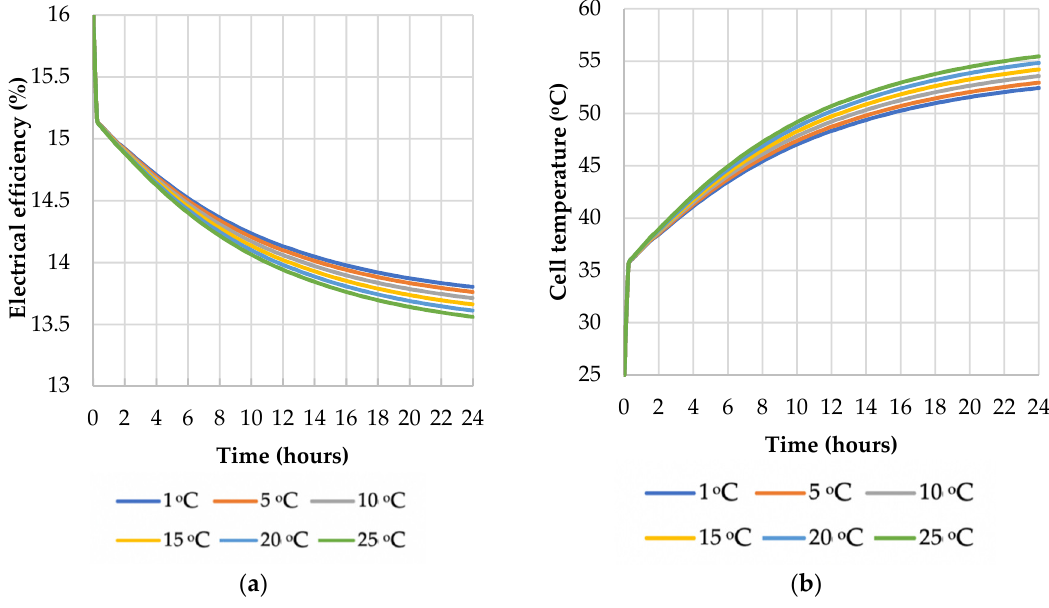
Figure 7. The variation of the ( a ) electrical efficiency; ( b ) cell temperature; as a function of the tank inlet temperature.